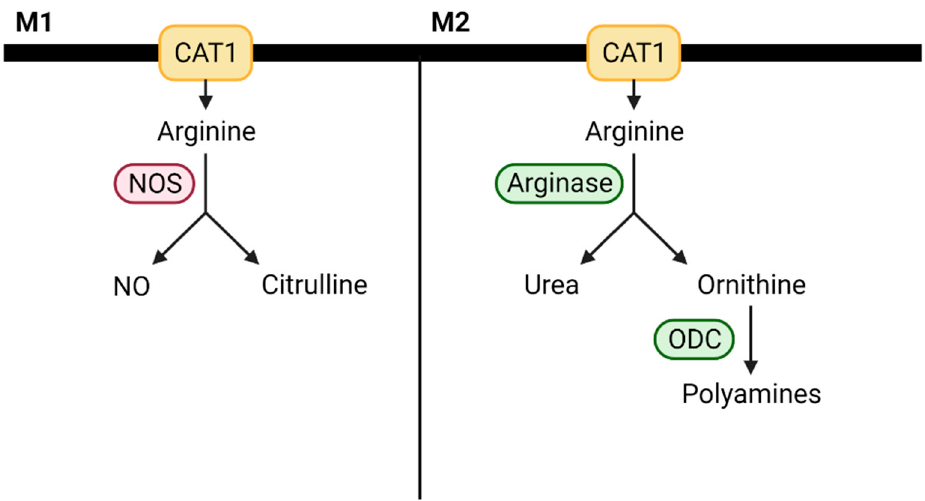
Figure 4. Alterations in arginine metabolism influence macrophage polarizaiton. CAT1—cationic amino acid transporter 1; NO—nitric oxide; ODC—ornithine